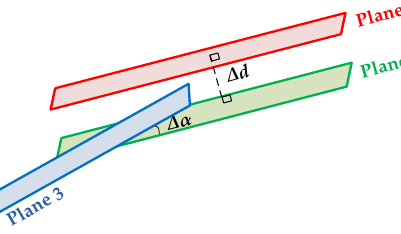
Figure 5. 2D representation of acceptable spatial and angular deviations within a given planar surface.